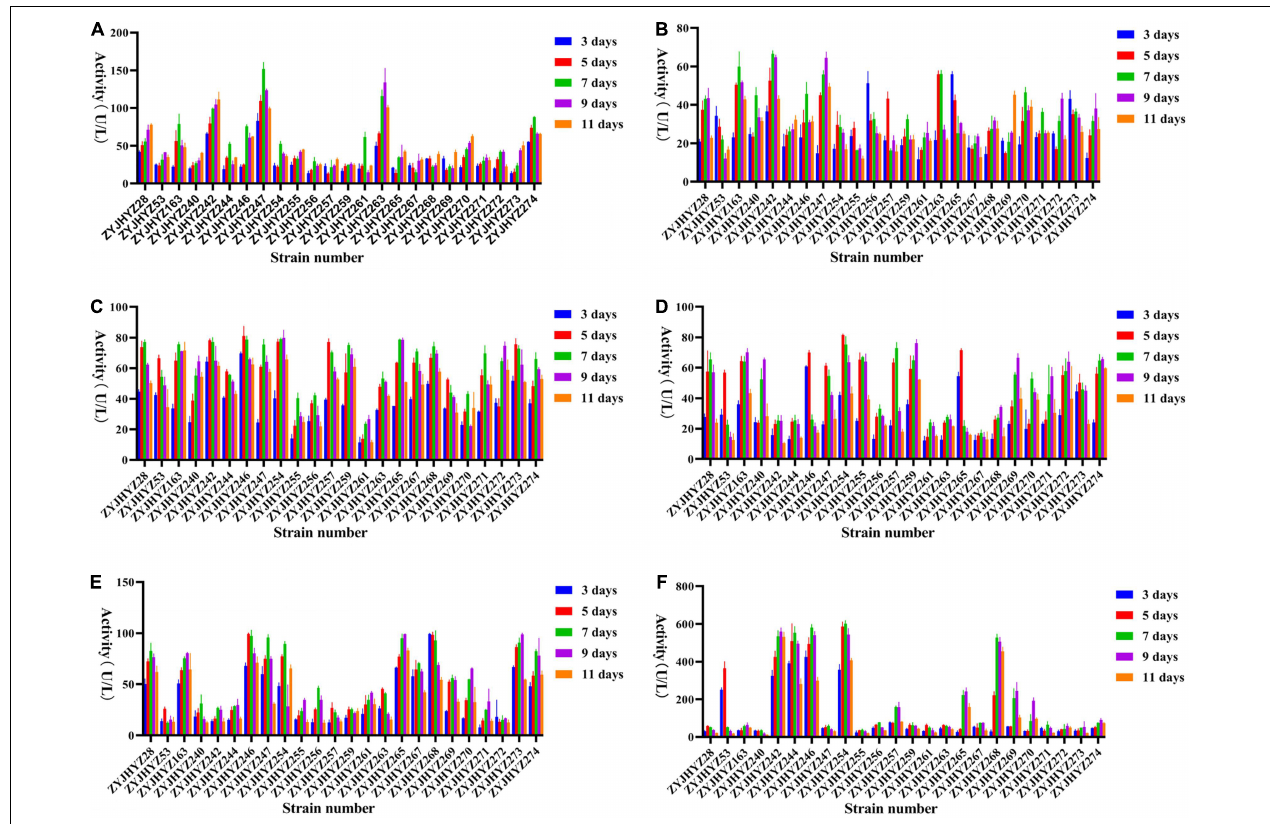
FIGURE 3 | Extracellular enzyme activities of selected fungi for pre-screening. (A) β -glucosidase, (B) Cellulase, (C) β -xylosidase, (D) Xylanase, (E) Laccase, and (F) Peroxidase activity of culture supernatant of fungi grew in 6% anti-biodegradable residue (in water) as the sole carbon source. The culture supernatants were collected on 3, 5, 7, 9, and 11 days after the inoculation. Three biological replicates were performed for each of the above